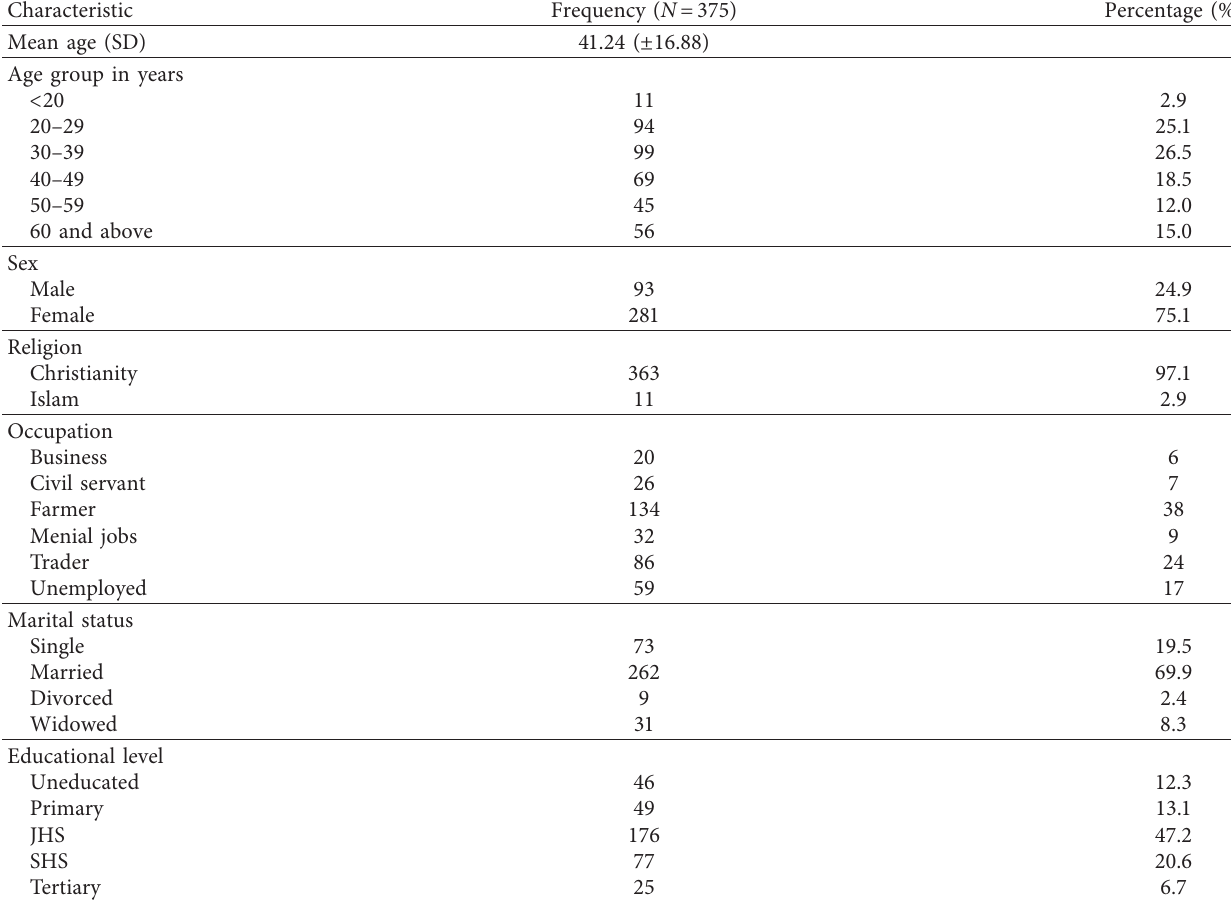
Table 1: Demographic characteristics of household members.